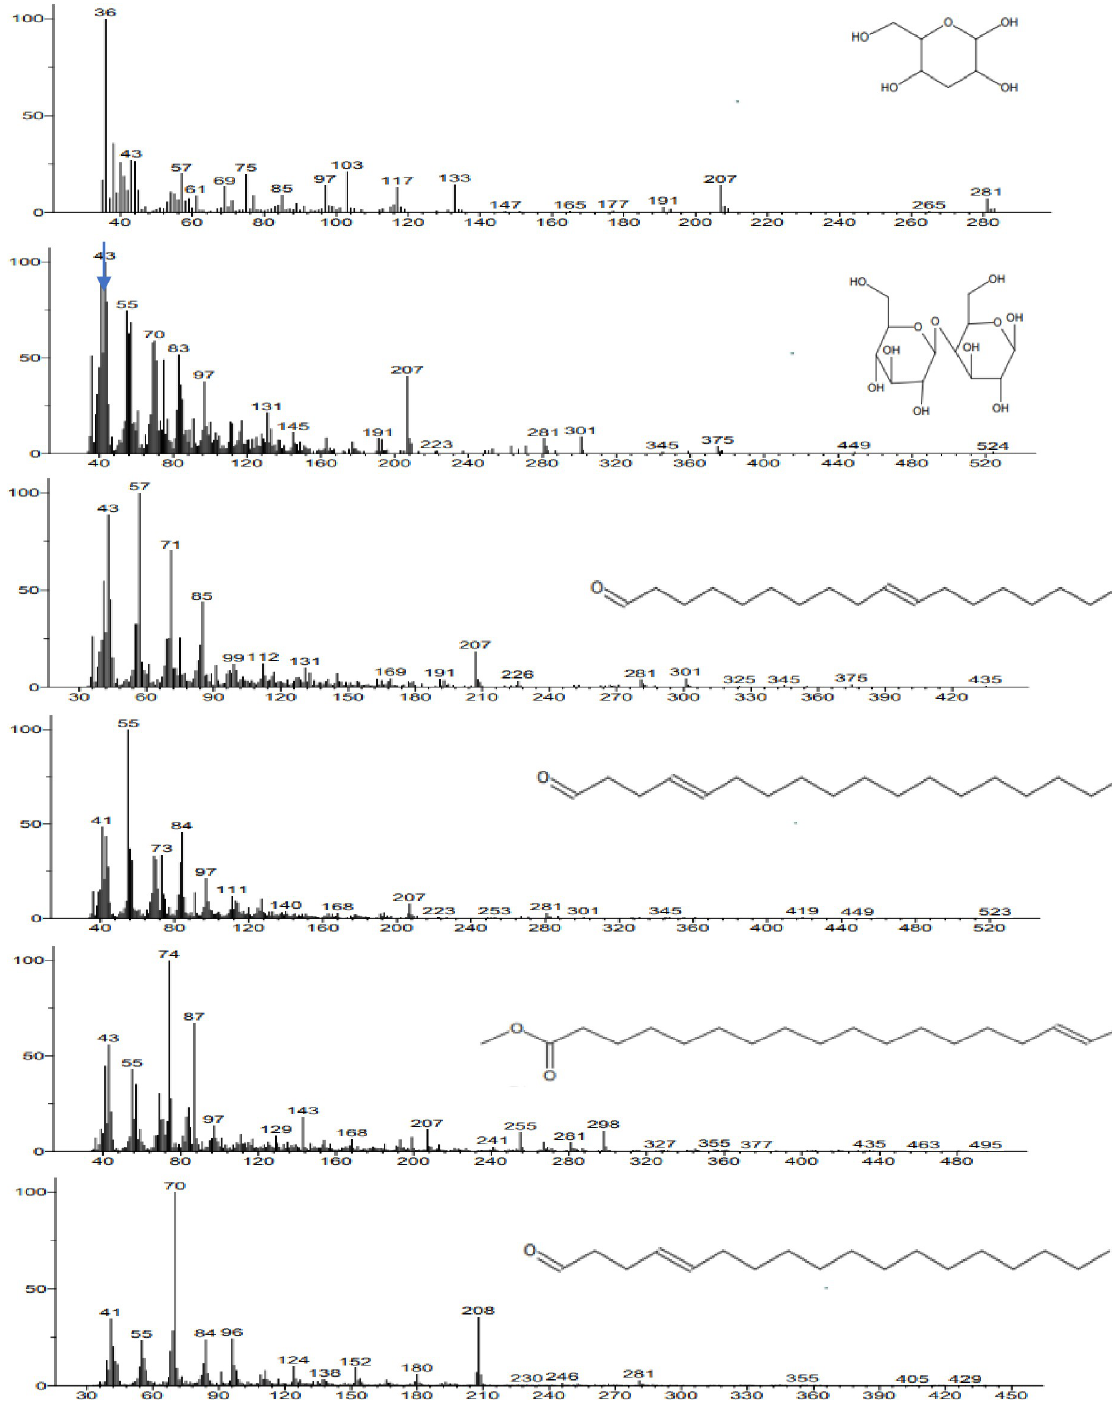
Fig 7. GC-MS spectrum of the extracted